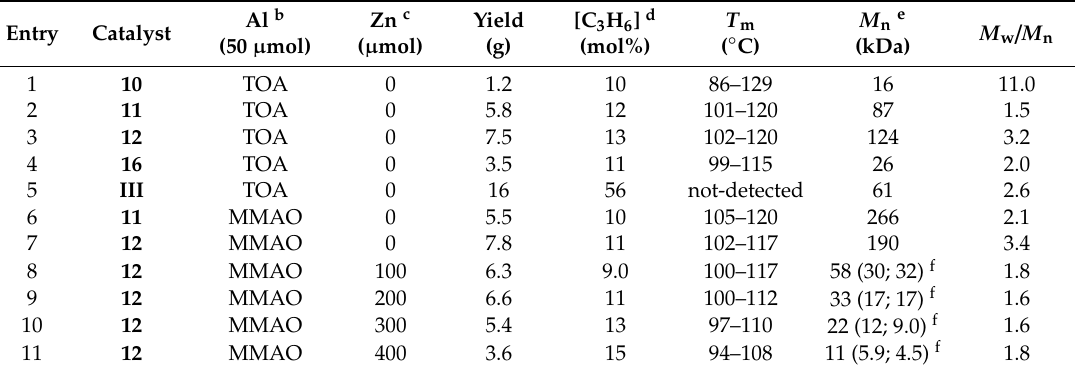
Table 1. Polymerization results a